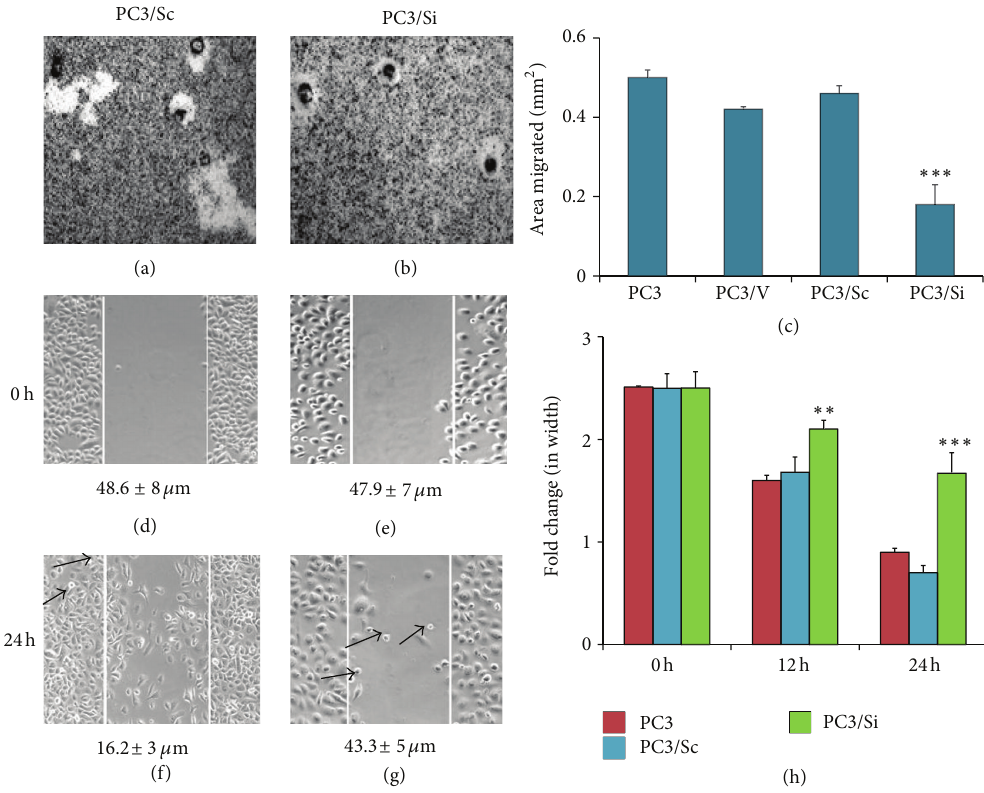
Figure 4: The effects of MMP9 knockdown on the migration of PC3 cells. Phase contrast micrographs of PC3/Sc and PC3/Si cells are shown (a) and (b); (d)–(g). (a)–(c) Phagokinesis assay. The area of the migratory track is seen free of the gold particles. PC3 cells were seen as black spots in the white tracks (a) and (b). Photographs were taken at the same magnification (100 × in the lower-power view). The motility was evaluated by measuring areas free of gold particles and represented as mm 2 (c). Results shown are mean ± SEM of three independent experiments. About 20 to 25 cell tracks from each experiment were measured; ∗∗∗ 𝑃 < 0.001 versus control cells (PC3, PC3/V, and PC3/Sc). (d)–(h) Wound closure assay. A representative wound closure assay before (d) and (e) and after (f) and (g) migration of PC3/Sc (d) and (f) and PC3/Si (e) and (g) is shown. Arrows in (f) and (g) point to dead floating cells. Data showed at the bottom of each panel (in 𝜇 m) represent mean ± SEM of an experiment performed in triplicates at 24 h. Statistical analysis (mean ± SEM) of three experiments performed in triplicates at 12 and 24h is provided as a graph (h). A significant decrease in the migration and wound closure was observed at 12 and 24 h in PC3 cells knockdown of MMP9 (PC3/Si) as compared with indicated control cells. ∗∗ 𝑃 < 0.01 , ∗∗∗ 𝑃 < 0.001 versus control cells (PC3/Sc and